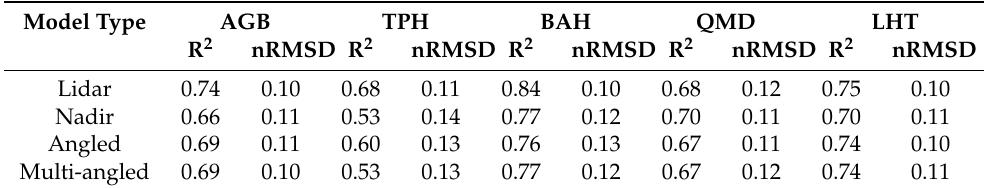
Table 4. Comparisons of plot-level observed forest metrics to predictions made by lidar and UAS DAP